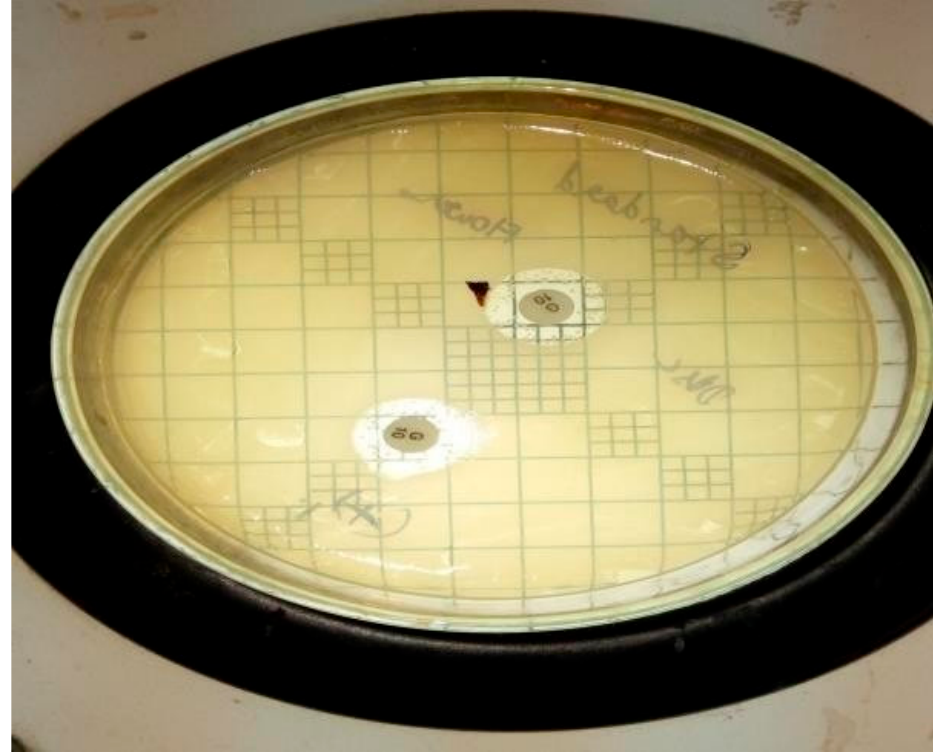
Figure 6. Standard Fluconazole on Candida albicans at 25mcg in duplicate at ZOI of 22.2 mm